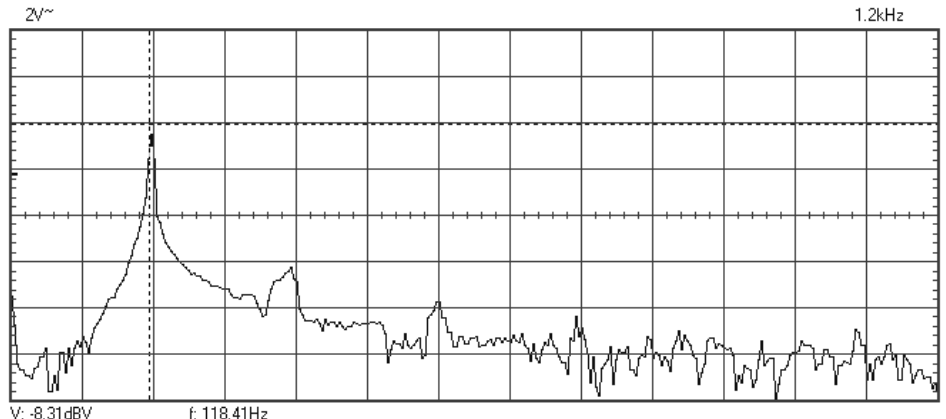
Figure 10. Amplitude spectrum recorded after 358,800 cycles at 119.6Hz.